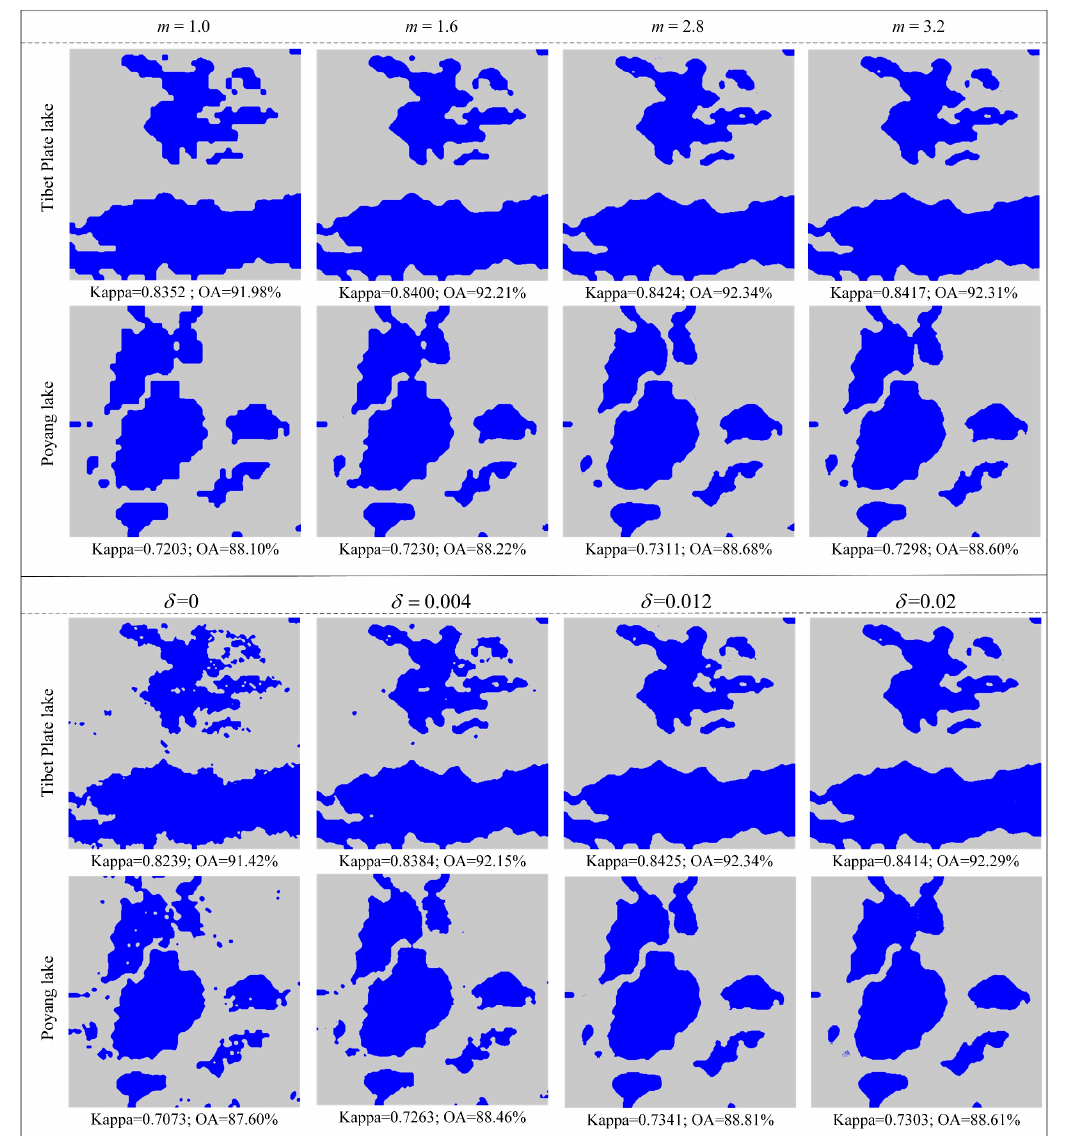
Figure 9. Resultant water body maps of USWBM with different values of m and δ .